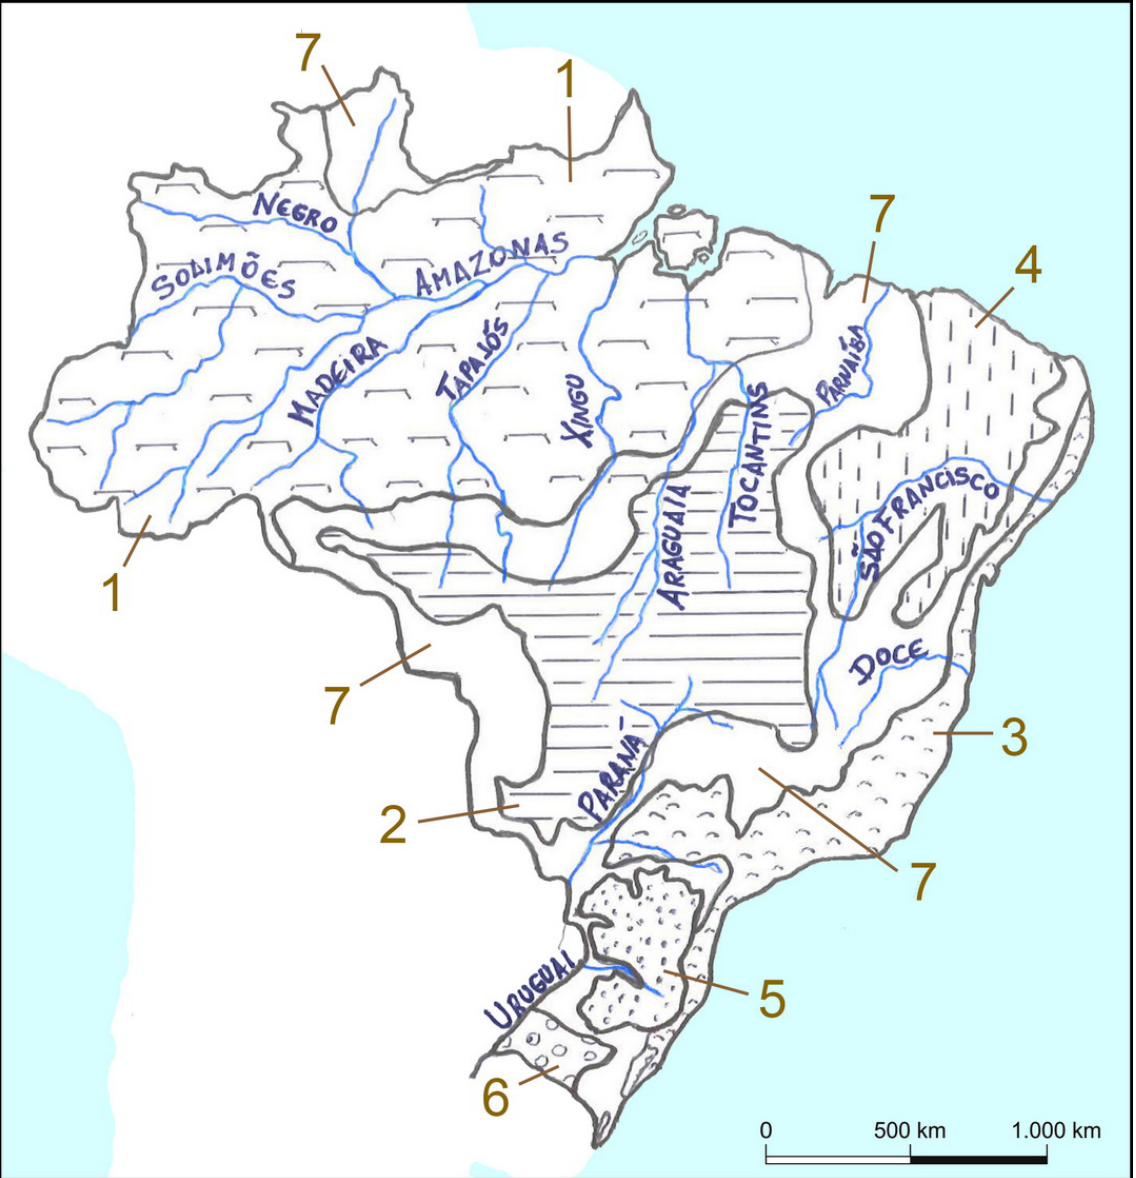
Figura 4. Principais domínios paisagísticos brasileiros segundo Ab’Sáber (1967), modificado: 1-Amazônico. 2- Cerrado. 3-Mares de morros. 4-Caatingas. 5-Mata de Araucária. 6-Pradarias. 7-Faixas de transição. Figure 4. Main Brazilian landscape according to Ab’Sáber (1967), modified: Amazônico. 2-Cerrado. 3-Mares de morros. 4-Caatingas. 5-Mata de Araucária. 6-Prairies. 7-Transitional